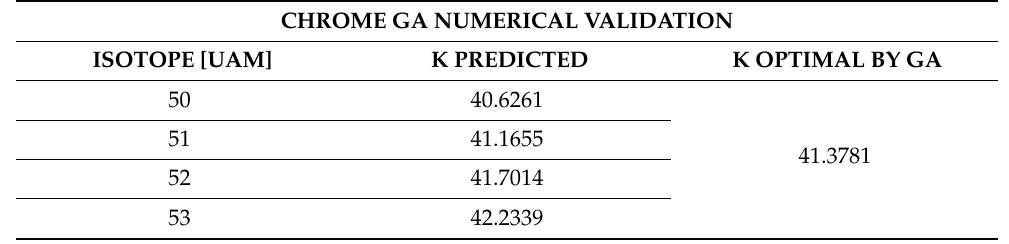
Table 7. GA program numerical results validation for chrome isotope effect model. For UAM the errors decrease.